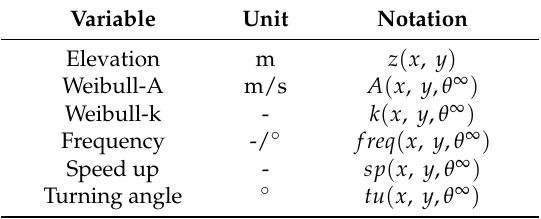
Table 1. Site condition variables important for AEP (annual energy production)